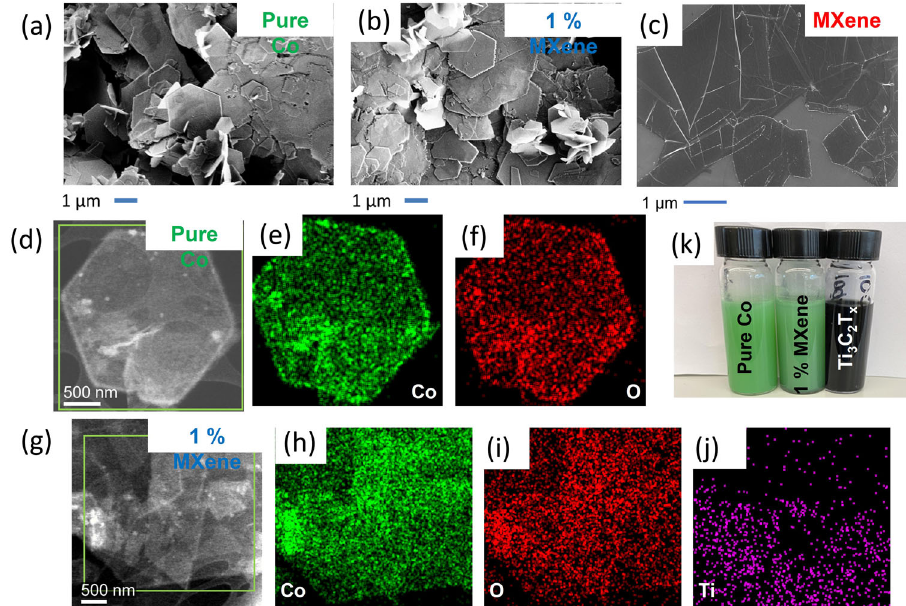
Fig. 1 Morphological characterization. Scanning electron microscopy images of ( a ) Pure Co, ( b ) 1% MXene, ( c ) pure MXene. d Scanning transmission electron microscopy image of the pure Co. e Energy dispersive X-ray map of the Co K α corresponding to d . f Energy dispersive X-ray map of the O K α corresponding to d . g Scanning transmission electron microscopy image of the 1% MXene. h Energy dispersive X-ray map of the Co K α corresponding to g . i Energy dispersive X-ray map of the O K α corresponding to g . j Energy dispersive X-ray map of the Ti K α corresponding to g . k Photo of the pure Co, 1% MXene and the pure MXene/Ti 3 C 2 T x ink